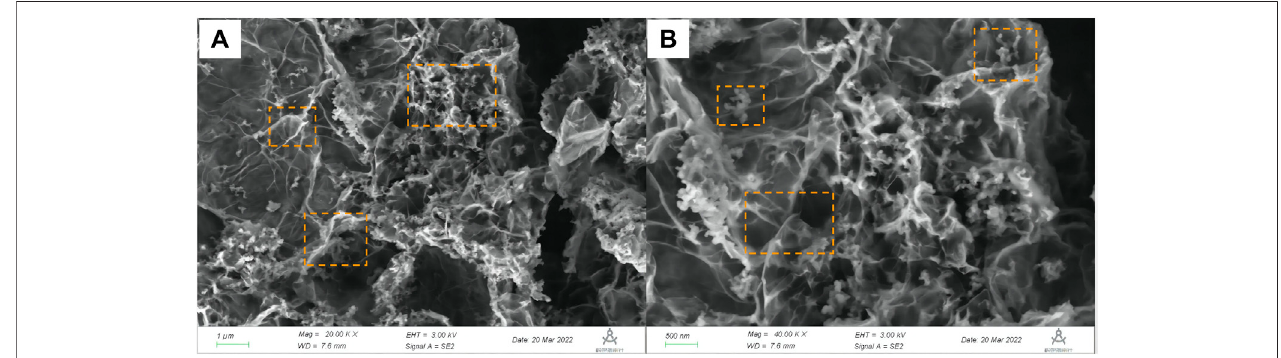
FIGURE 3 | SEM image of the RGO-CB/CIP composite. (A) The interface formed by the folding of RGO itself; (B) CIP and CB are attached to the RGO surface to form a heterogeneous interface.